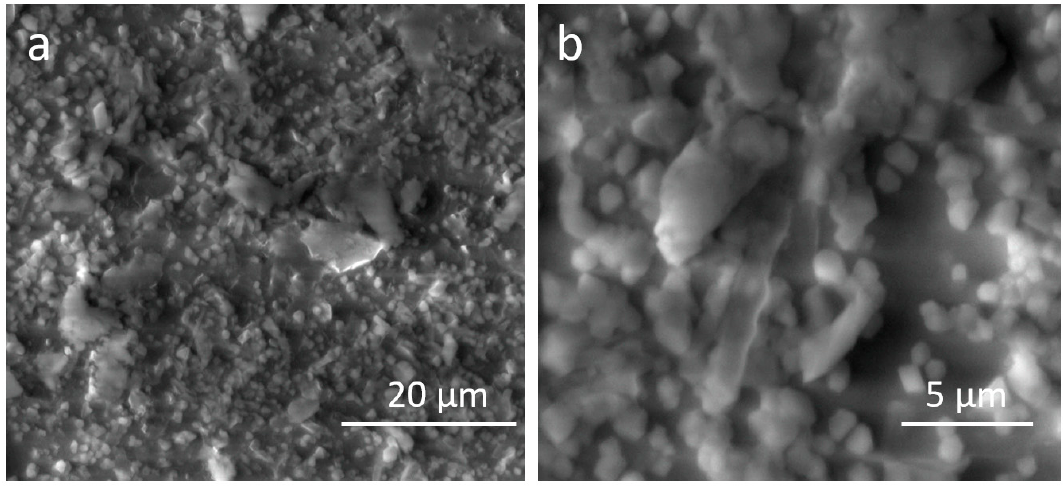
13 of 18 Figure 7. Fourier transform infrared (FT-IR) spectra of MAC, BSA, and 0.5BMAC7/1 80. 3.3. Morphological Analysis The surface morphology of the nanogels based on BSA and MAC was evaluated by SEM analysis. Figure 8 presents SEM images of 0.5BMAC7/1 80 nanogels, which are characterized by better